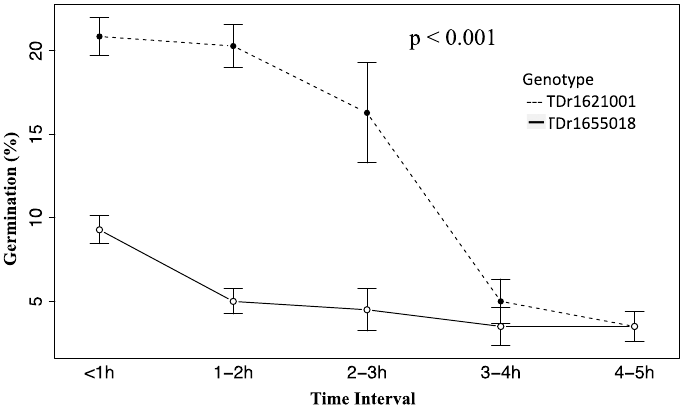
Figure 1. Effect of the delay between pollen collection and culture on percentage germination of two D. rotundata genotypes ( p < 0.001). Table 1. Effects of the interactions between the incubation duration and temperature and the agar concentration on percentage germination of pollen from two D. rotundata genotypes. Genotype